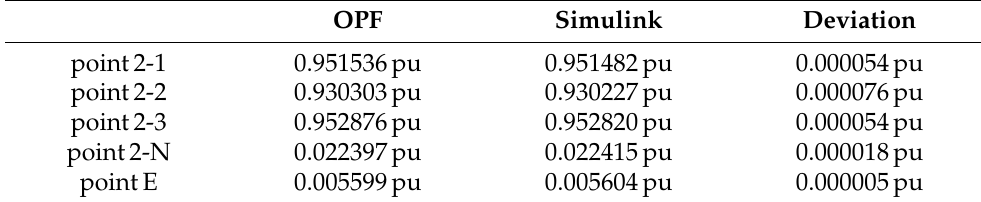
Table 4. Calculated voltages for different